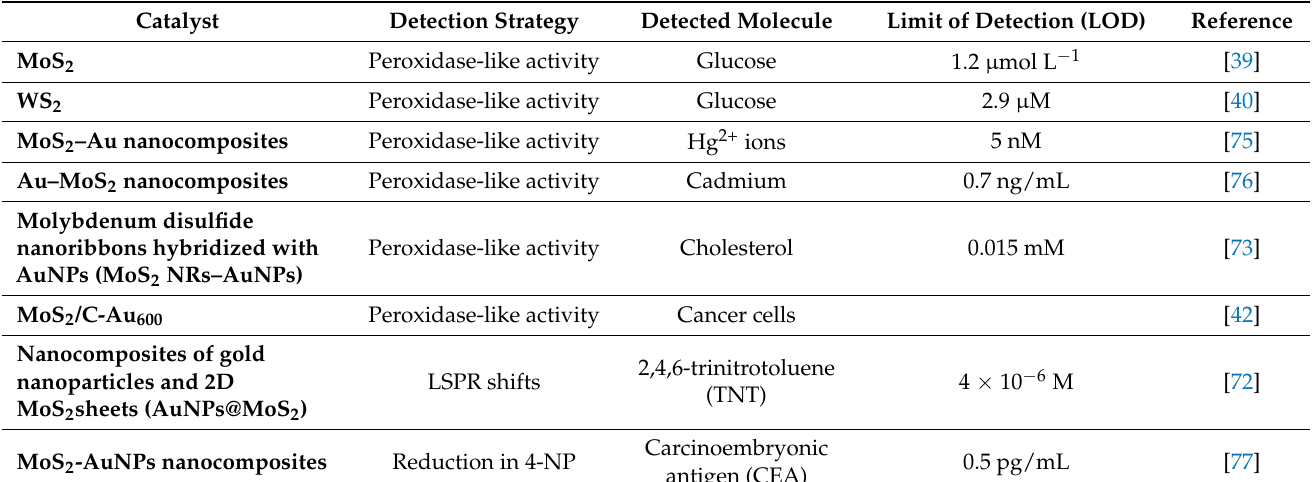
Table 1 contains a summary of the different colorimetric sensing based on hybrid compounds. Table 1. Different colorimetric detection strategies based on 2D nanomaterials and hybrid compounds with plasmonic metal